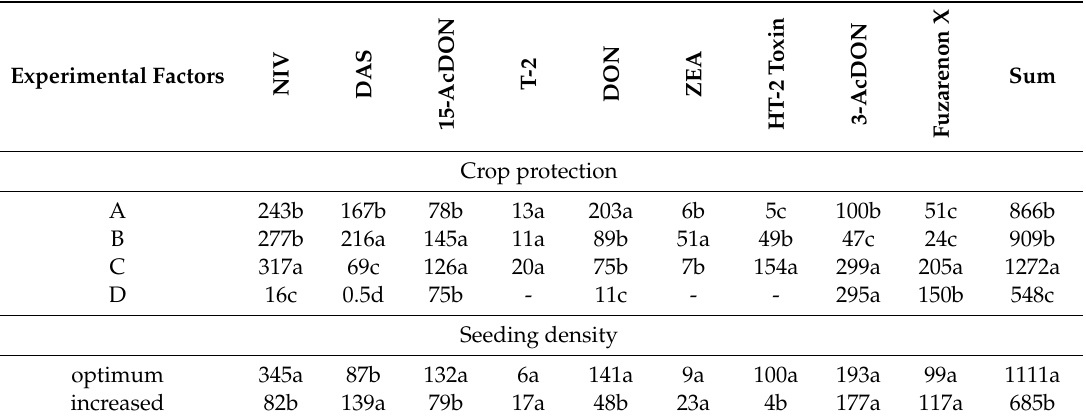
Table 9. Mycotoxin content in wheat grain of the spelt wheat cv. “Schwabenspelz” (concentration of mycotoxins µ g kg − 1 of grain) (mean for 2014–2015). NIV—nivalenol,